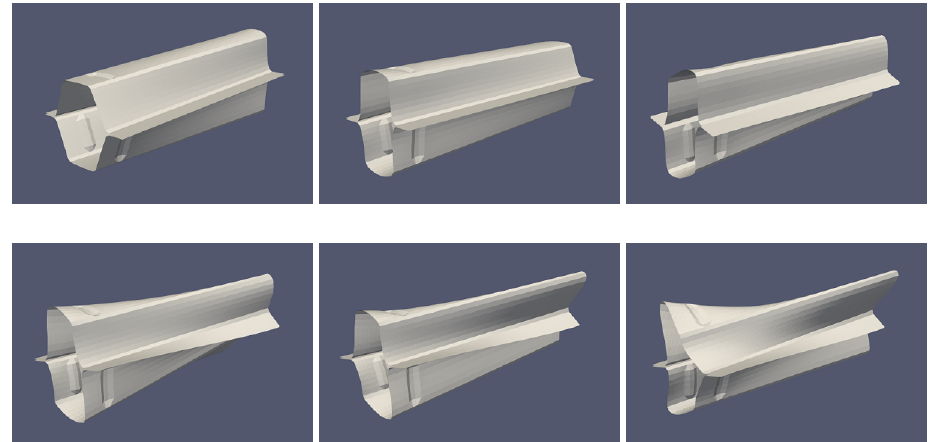
Figure 8. ( top-left ) First mode; ( top-right ) Second mode; ( middle-left ) Third mode; ( middle-right ) Fourth mode; ( bottom-left ) Fifth mode; and ( bottom-right ) Sixth